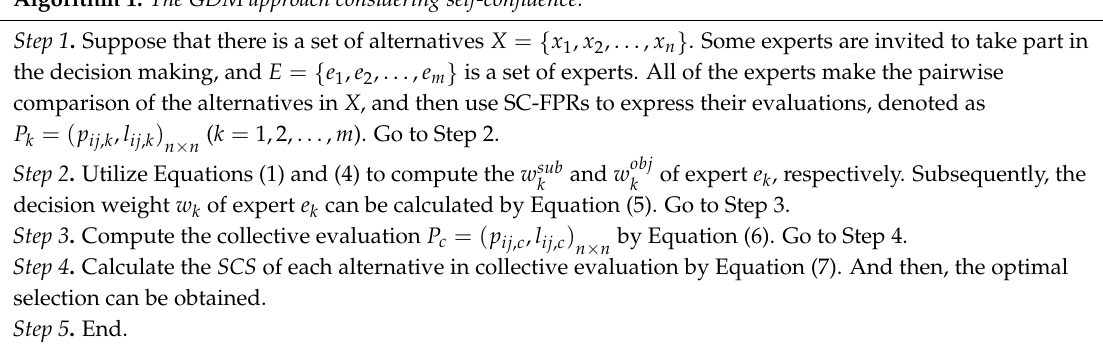
Algorithm 1. The GDM approach considering